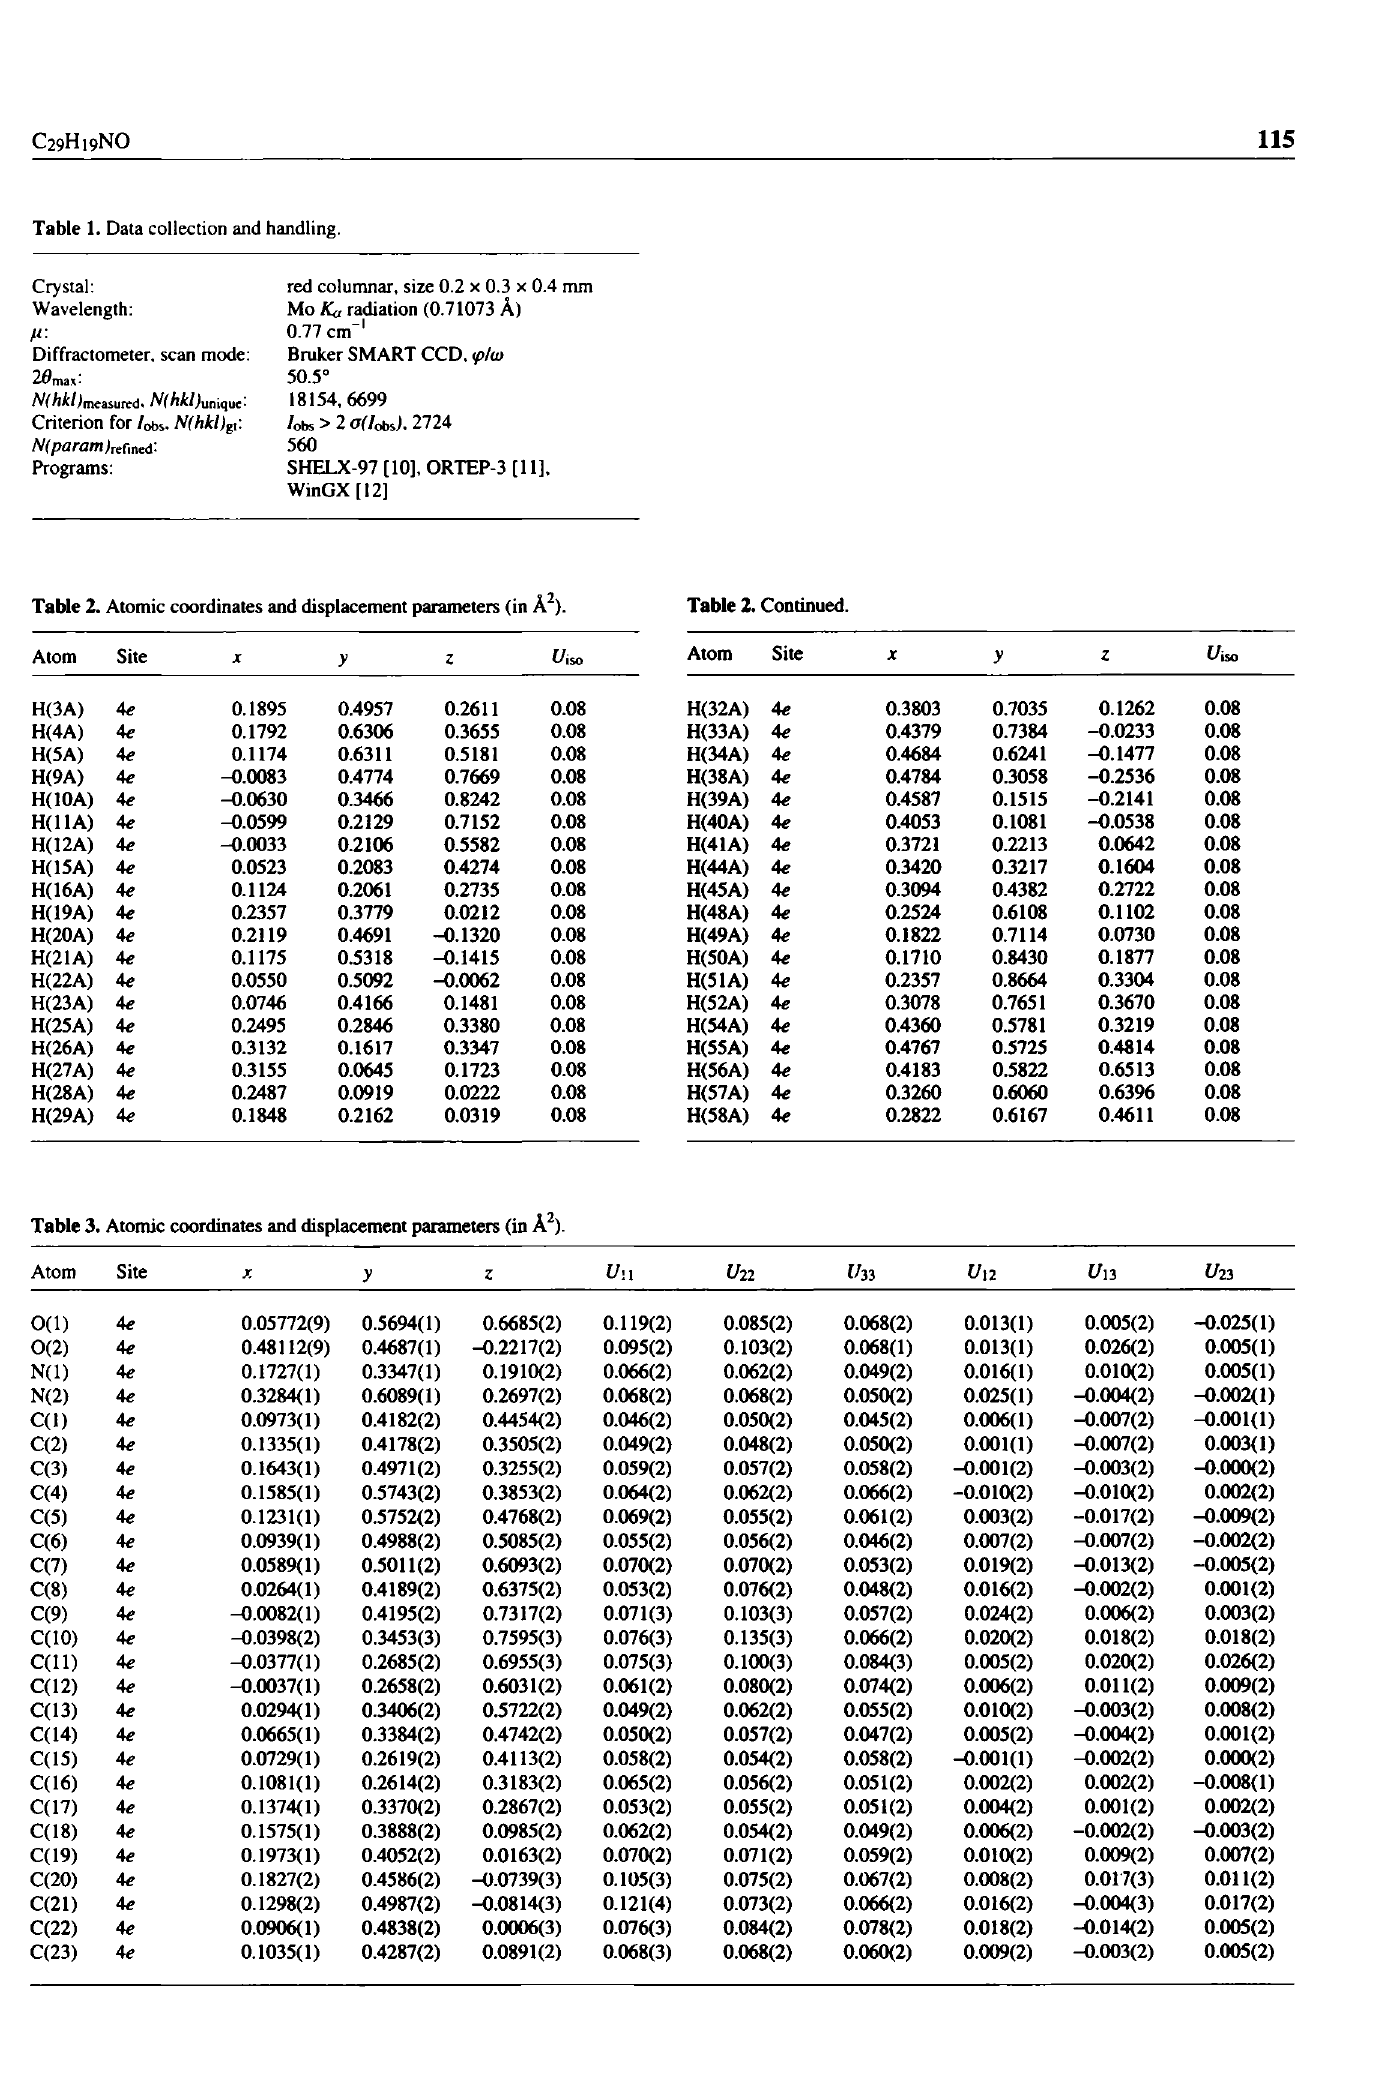
Table 2. Atomic coordinates and displacement parameters (in A 2 ). Table 2. Continued.